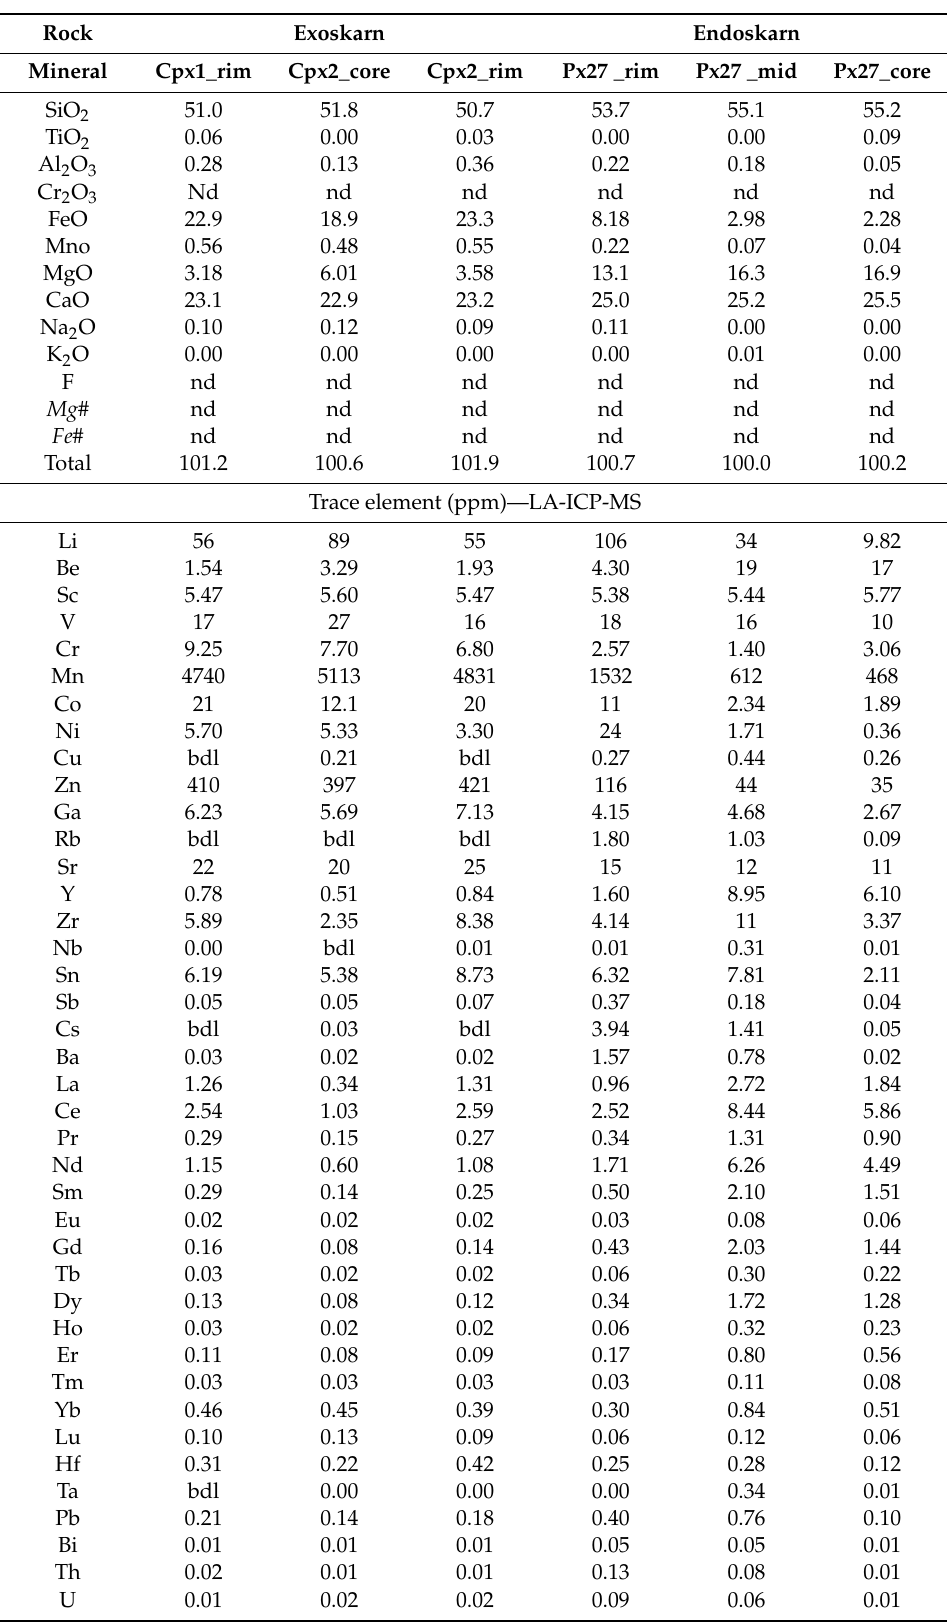
Table 4. Electron microprobe and LA-ICP-MS analyses for pyroxene crystals from BM.